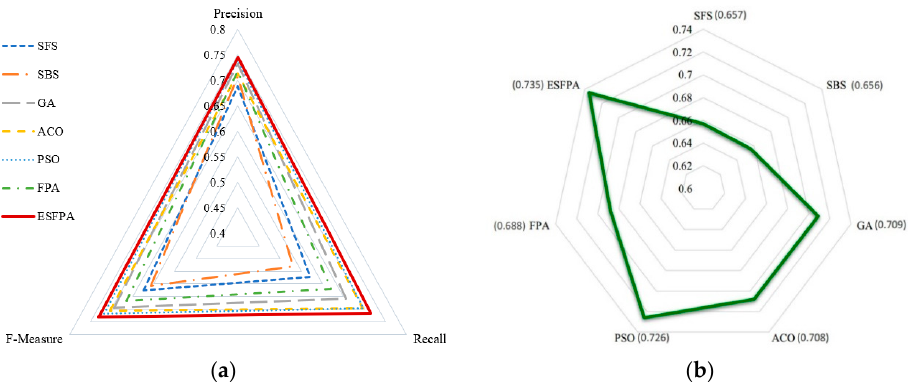
Figure 4. Comparison of our ESFPA method and some well-known feature selection methods. ( a ) shows the comparison results in terms of Precision, Recall, and F-Measure; ( b ) shows the comparison results in terms of AUC scores. Table 1. Comparing the performance of different feature selection methods on balanced dataset.